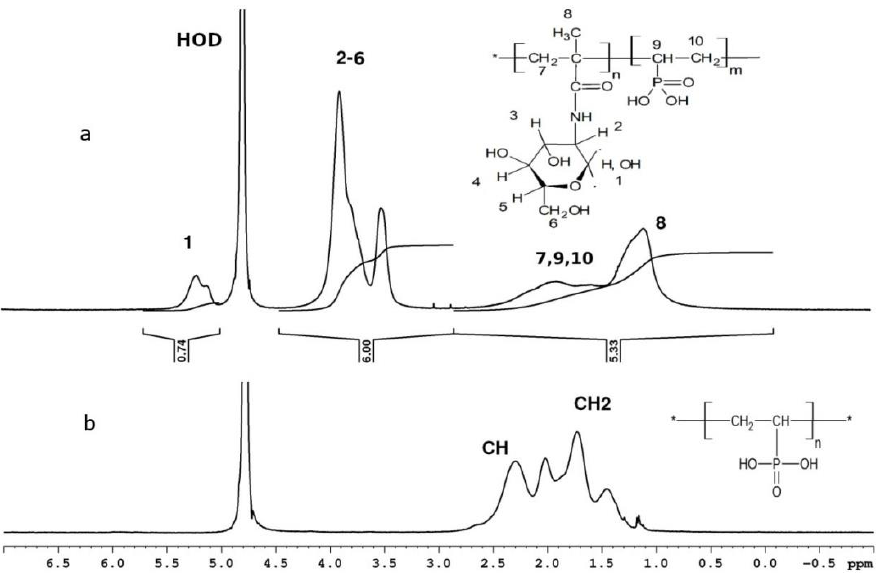
Figure 5. 1 H NMR spectra of MAG-VPA copolymer (Experiment 3, Table 1) ( a ), PVPA ( b ) in D 2